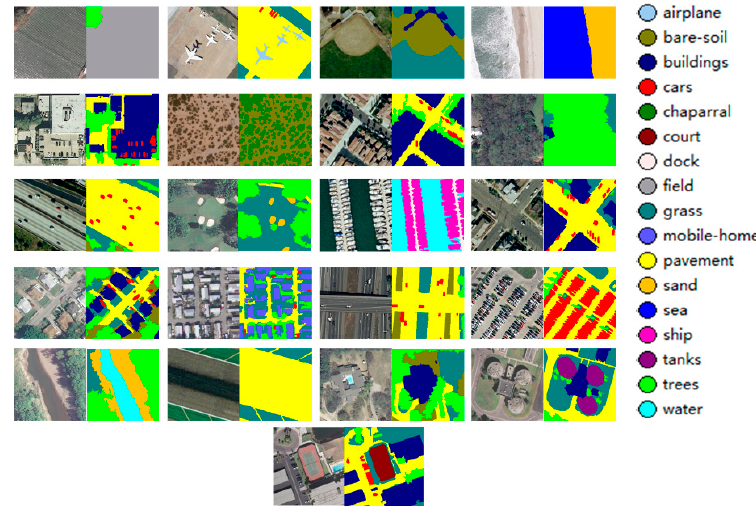
Figure 2. Example images and corresponding labeling results. Table 1. The number of images present in the dataset for each class label.